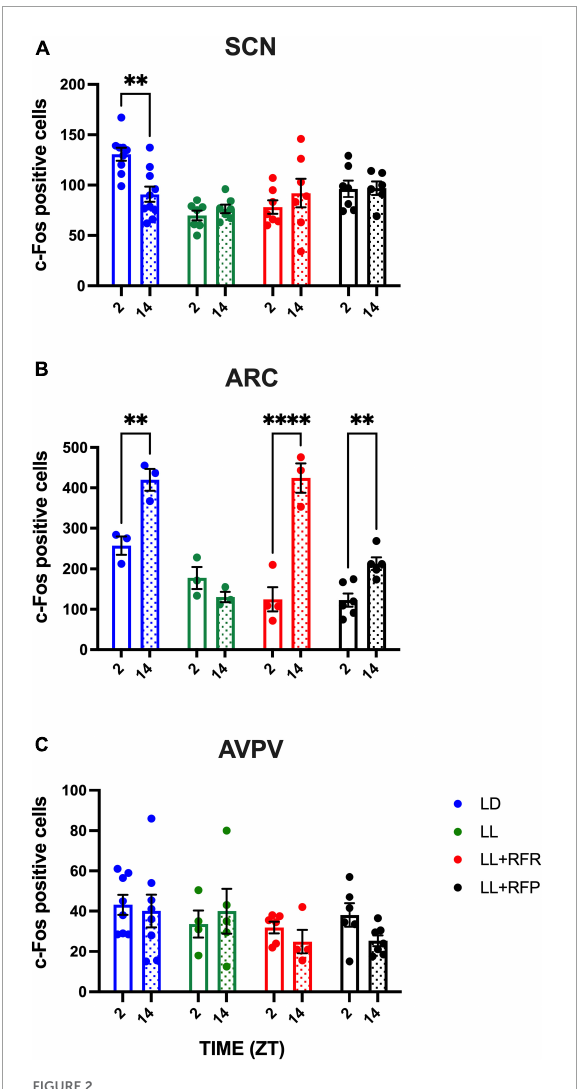
FIGURE2 Day–night c-Fos positive cells in (A) the suprachiasmatic nucleus (SCN), (B) the arcuate nucleus (ARC), and (C) the posterior ventral preoptic area (AVPV), in rats exposed to a light–dark cycle during the baseline (BL, blue bars), to constant light (LL, green bars), to LL followed by 3 weeks of the 12-h restricted feeding schedule as a rescue strategy (LL + RFR, red bars), or to 6 weeks LL paired simultaneously to the 12-h restricted feeding schedule as a preventive strategy (LL + RFP, black bars). For each group, empty bars represent day (ZT2) and dashed bars represent night (ZT14). Data are expressed as the mean ± SEM; n = 4/time/group. Asterisks indicate a statistical difference between the day and the night values in the specified group; ∗∗ P < 0.001; ∗∗∗∗ P < 0.0001.